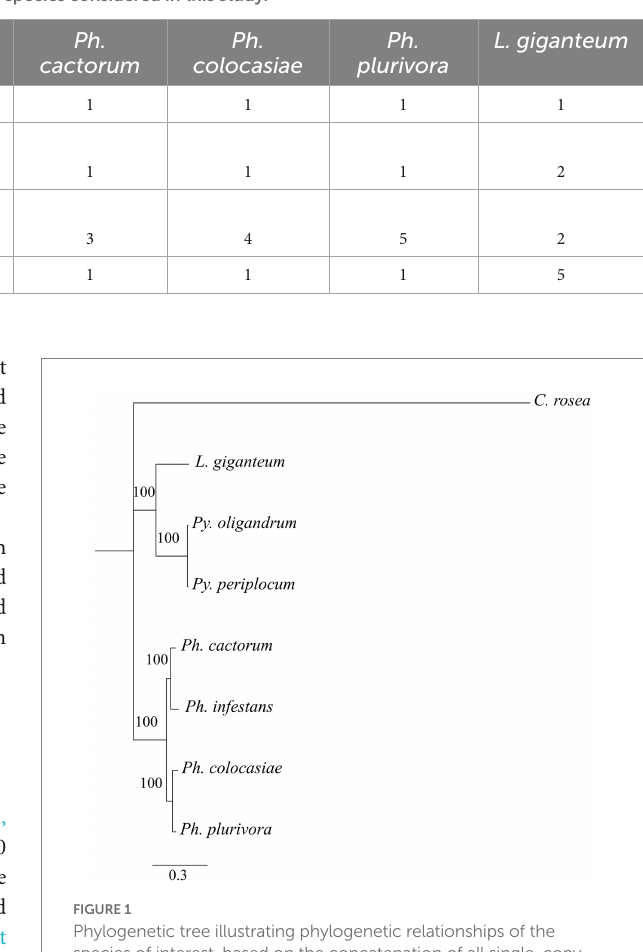
FIGURE 1 Phylogenetic tree illustrating phylogenetic relationships of the species of interest, based on the concatenation of all single-copy proteins present in every species. Rapid bootstrap support ( ≥ 60%) values from 100,000 iterations are associated with